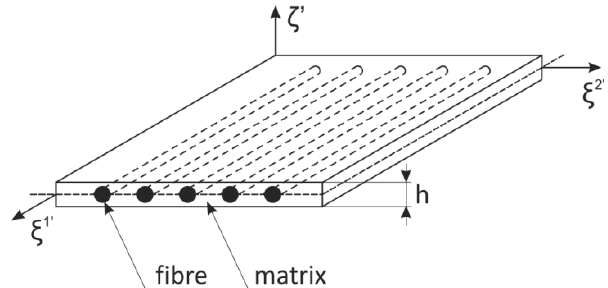
Figure 16. Composite with defined UD–layer.